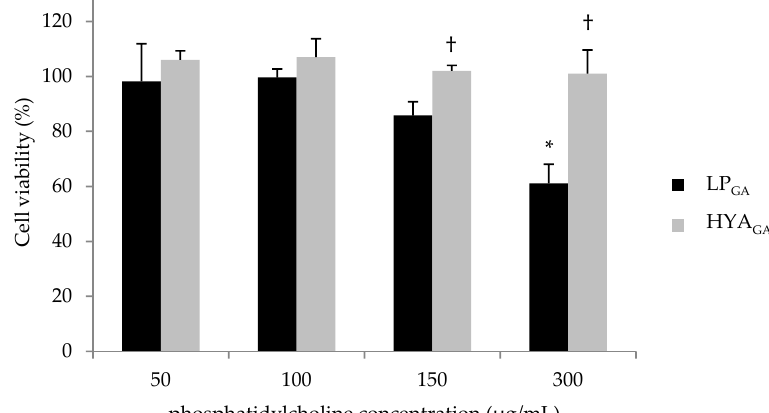
Figure 3. Viability of 3T3 cells after different dilutions of LP GA and HYA GA treatment for 24 h. Results are shown in mean percentage respect to the controls taken as 100% (mean ± SD, n = 3) Significance indicated by * p < 0.05 compared with the control and † p < 0.05 compared with LP GA .